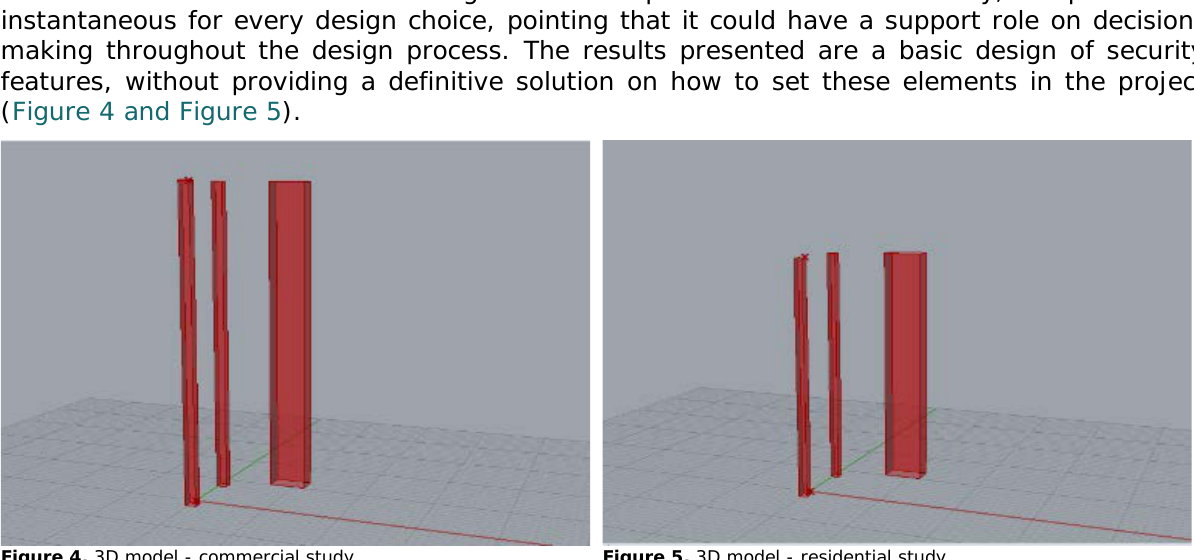
Figure 4. 3D model - commercial study. Figure 5. 3D model - residential